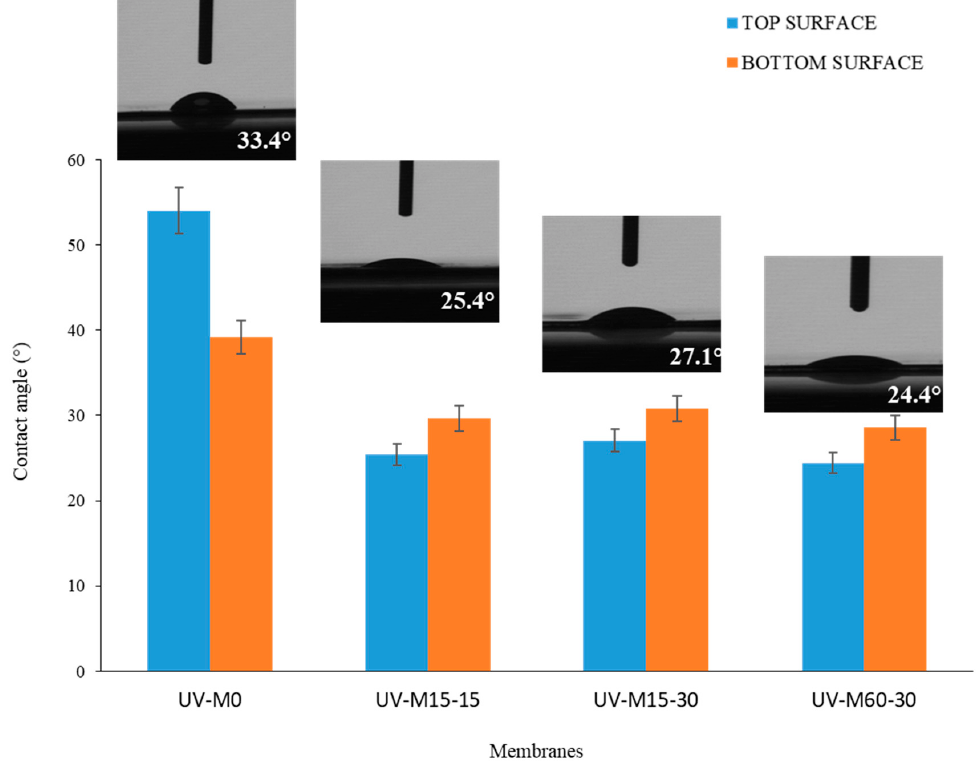
Figure 5. The CAw of the membranes with and without the UV hydrophilization procedure . The control membrane (UV-M 0 ) presented an average CAw of 54 ± 0.5, while the membranes exposed to the hydrophilization procedure showed a CAw of less than 30°. This result indicates that the hydrophilic treatment decreased the Caw and enhanced the hydrophilic nature of the membranes, thereby enhancing their performance in terms of water permeability. Theoretically, the adsorption and deposition of hydrophobic pollu- tants onto the membrane surface should be reduced [54]. It was observed (Figure 5) that